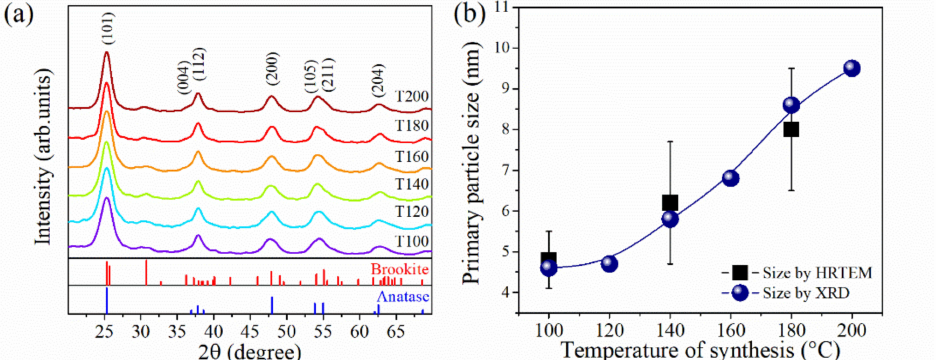
Figure 1. ( a ) Evolution of the XRD patterns of samples obtained at 100–200 ◦ C. ( b ) Comparison of the mean primary particle size determined by XRD and HRTEM analysis for all synthesized TiO 2 NPs. Representative HRTEM images and size distribution analysis are shown in Figure A2.